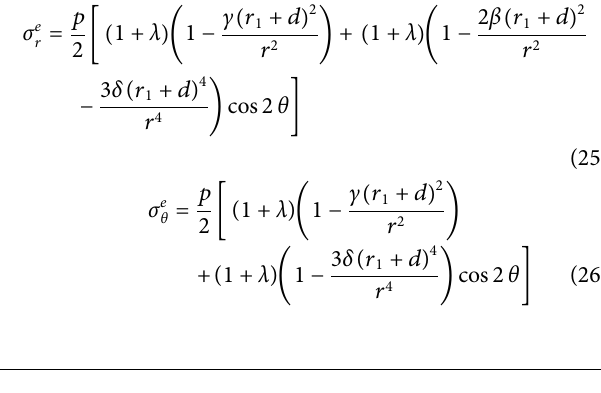
TABLE 5 | Mechanical parameters of numerical model.